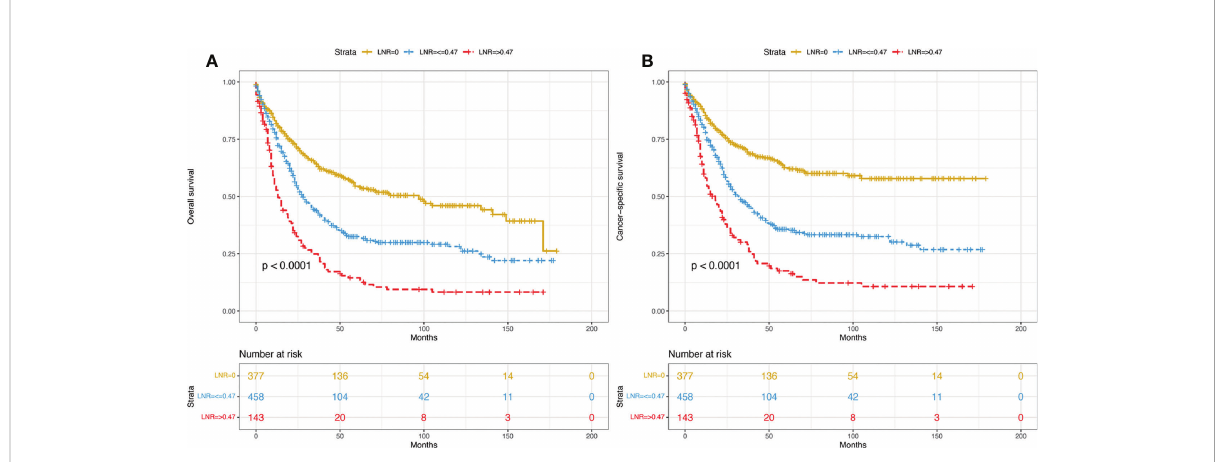
FIGURE 2 Kaplan – Meier curves of OS (A) and CSS (B) for all included patients strati fi ed by LNR. OS, overall survival; CSS, cancer-speci fi c survival; LNR, lymph node ratio.